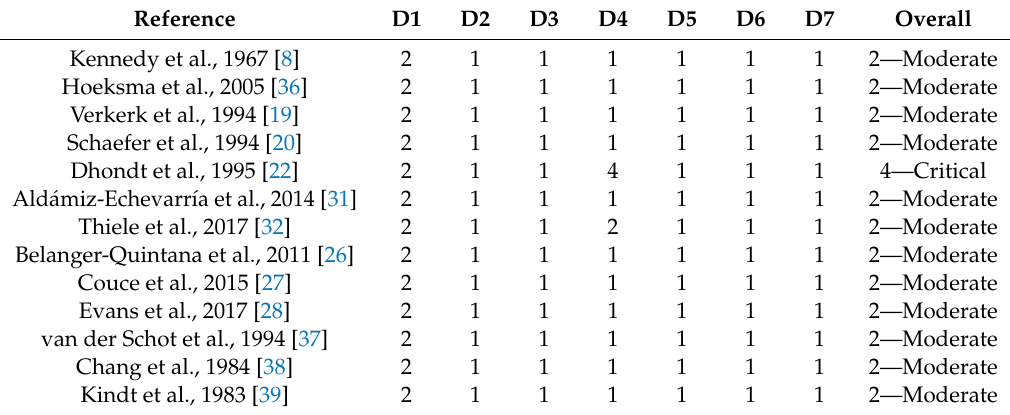
Table 4. Risk of bias assessment according to the ROBINS-I